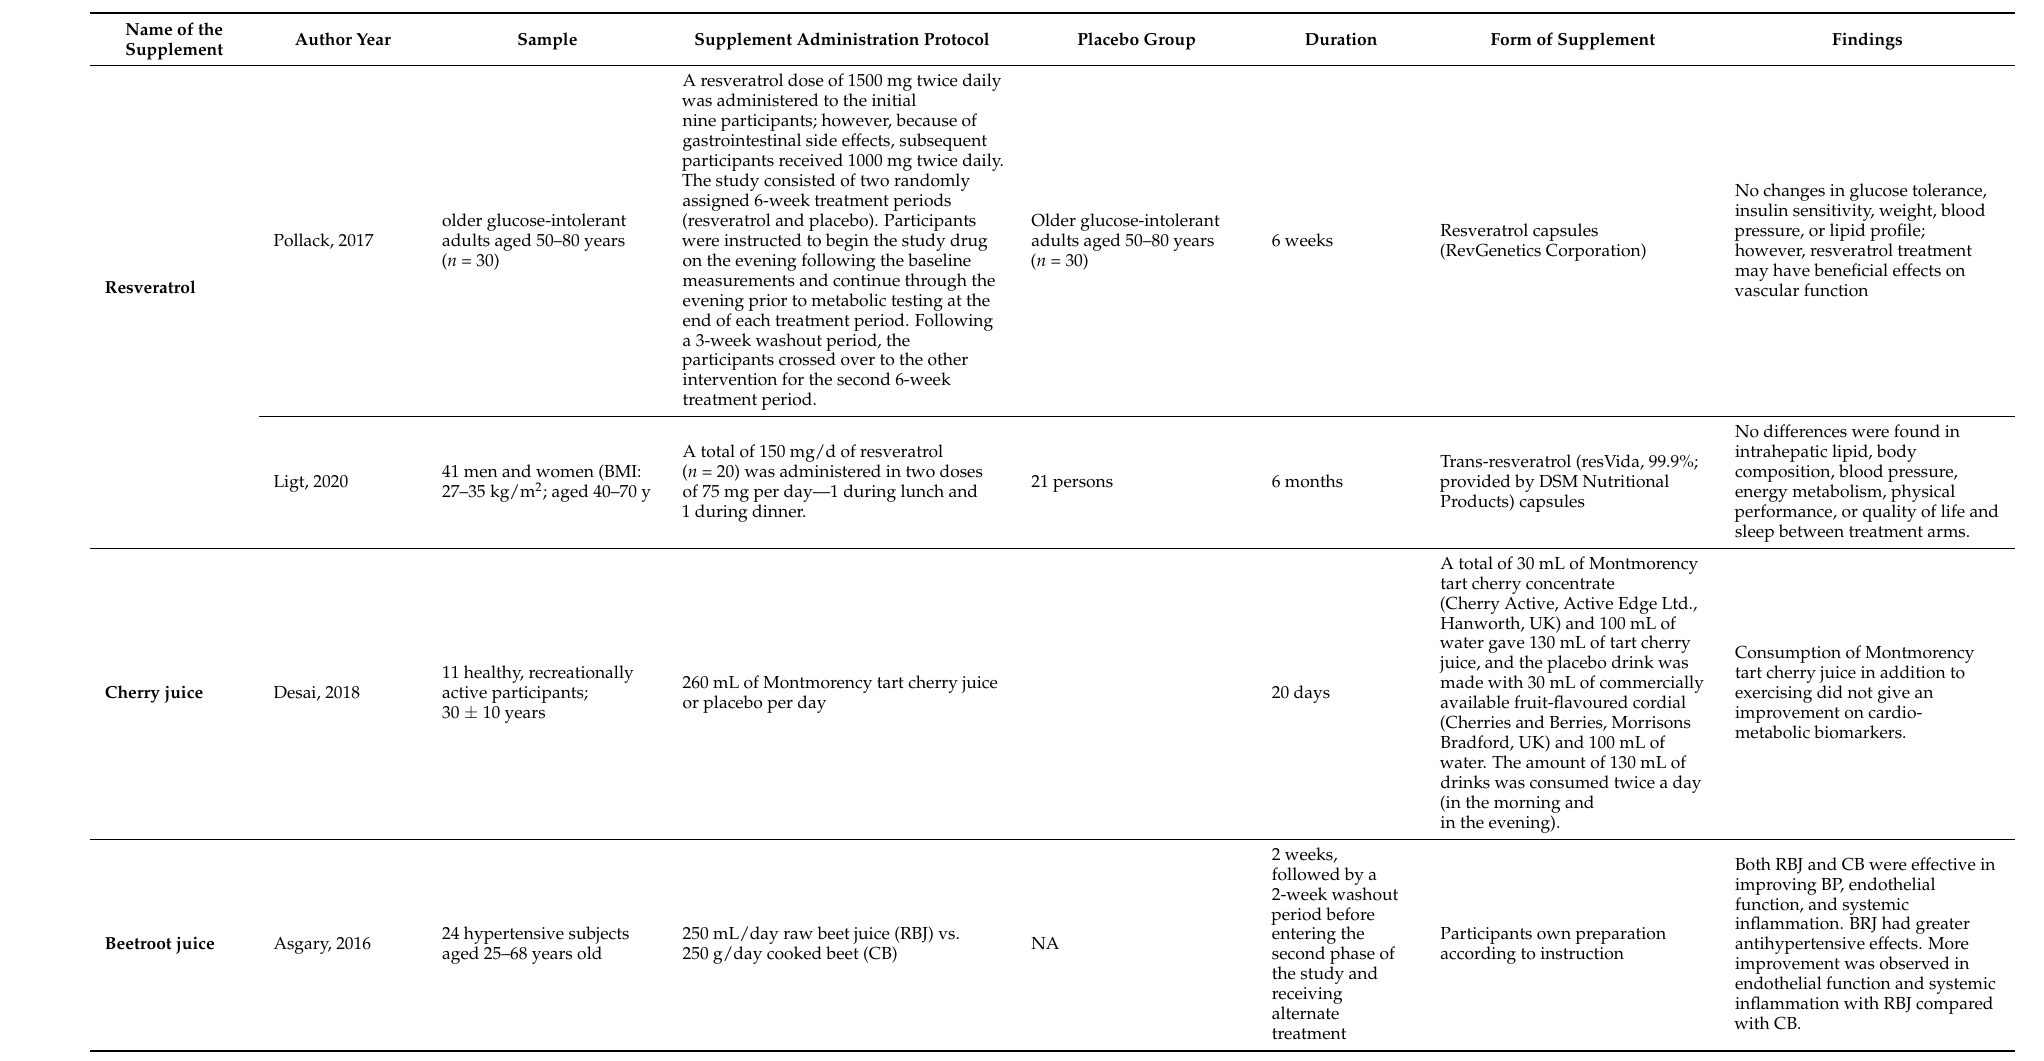
Table 2. Supplement effectiveness review based on the included articles ( n =